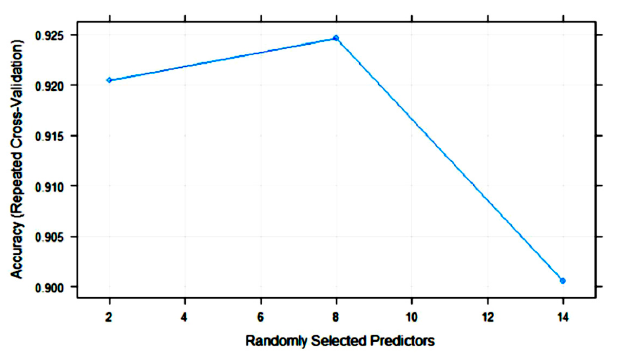
Figure 7. Change in the accuracy of random forest (RF) models with the number of randomly selected predictors (mtry).